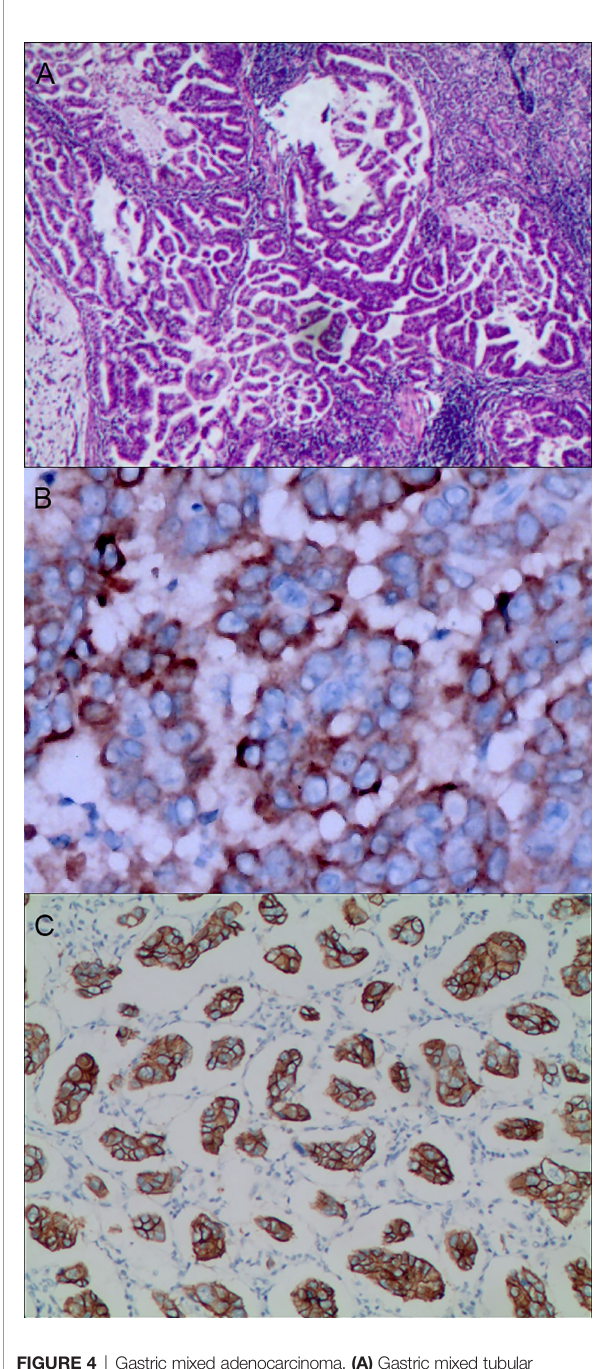
FIGURE 4 | Gastric mixed adenocarcinoma. (A) Gastric mixed tubular adenocarcinoma-micropapillary carcinoma (20% tubular adenocarcinoma/80% micropapillary carcinoma), hematoxylin and eosin staining × 100. (B) Positive MUC1, gastric invasive micropapillary carcinoma. The micropapillary carcinoma cells were clustered with an irregular central cavity and a surrounding space with the stroma. En Vision method × 400. (C) Positive EMA. The micropapillary carcinoma cells were reversed poleward, presenting an inside-out shape. En Vision method × 200. MUC1: bovine mucin